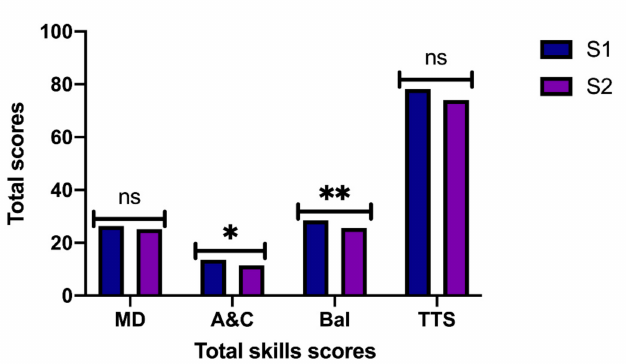
Figure 2. Semester of birth according to total skill scores. MD: Manual dexterity; A&C: Aiming and Catching; Bal: Balance; TTS: Total Test Score. Note: * p < 0.001 different between S1 vs. S2; ** p < 0.05 different between S1 vs. S2. ns p > 0.005 no significative